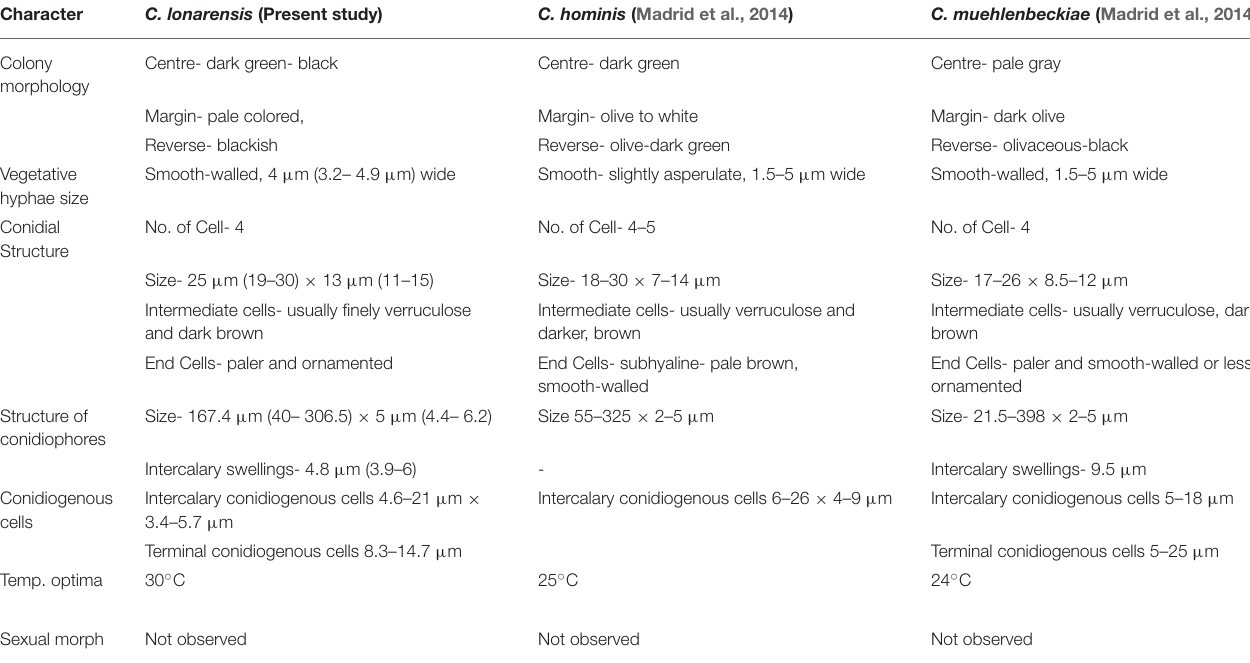
TABLE 4 | Comparison of morphological characters of Curvularia lonarensis , C. hominis , C. muehlenbeckiae .